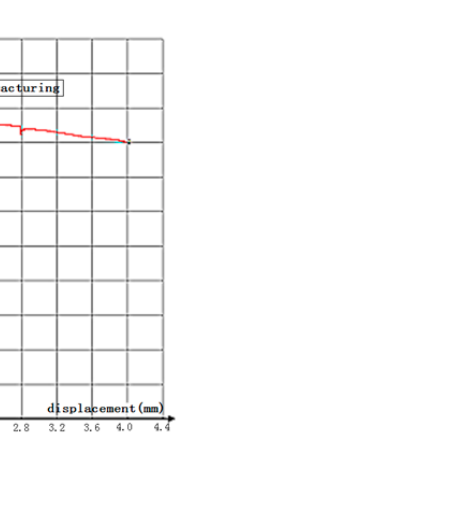
Figures 11. ( a ) Load–deformation curve of coating with 8% Co, ( b ) Specimen after bending test.